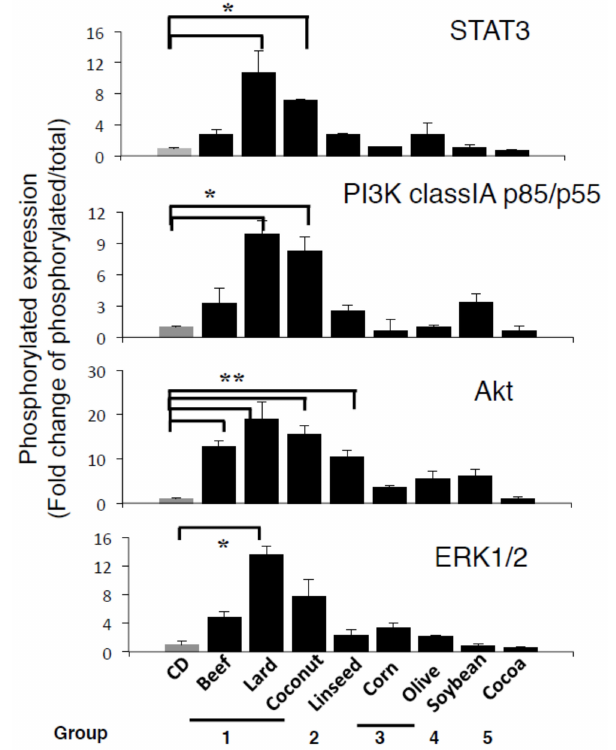
Figure 5. Upregulation of leptin receptor signaling in the gastric mucosa of group 1-type HFD-fed wild-type (WT) mice. Gastric sections stained for the phosphorylated STAT3, PI3K class I p85 / p55, Akt, and ERK1 / 2, and total STAT3, PI3K class I p85 / p55, Akt, and ERK2 in the gastric mucosa of WT fed for 12 weeks. Quantification of each expression level was performed by using ImageJ software described in the Methods. Data, shown as mean ± SD of eight mice were analyzed by the one-way ANOVA followed by Holm-Sidak post-hoc test for multiple comparisons. * p < 0.05, ** p <